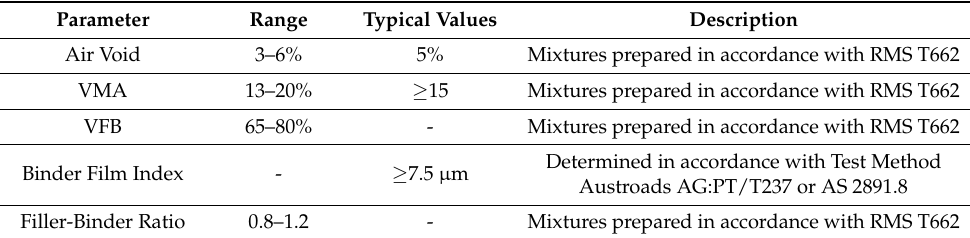
Table 4. Volumetric parameters requirements for DGA AC14